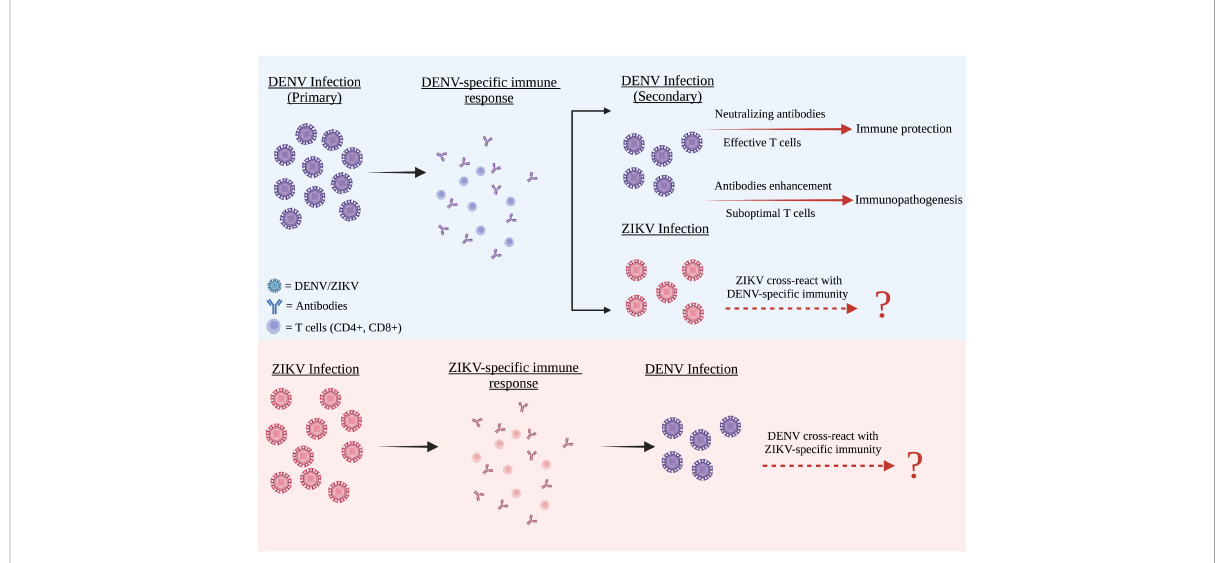
FIGURE 1 The cross reactivity between DENV and ZIKV infection. DENV and ZIKV were structurally and genetically highly similar to one another. Both these two fl aviviruses have a strong humoral cross-reactivity with each other. After primary infection, all four DENV serotypes including ZIKV are partially cross-reactive with the DENV antibodies present in the DENV-infected patients. These antibodies often have lower avidities and weak neutralizing abilities. In both fl aviviruses, weak antibody responses can promote an antibody-dependent enhancement (ADE) condition, whereas strong antibody responses neutralize the second virus infection and cause negligible